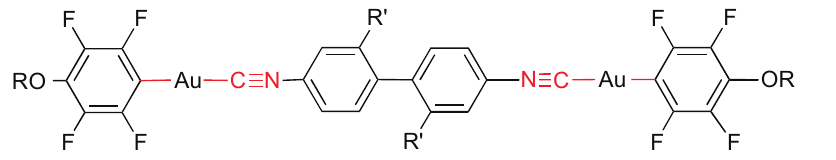
Figure 18. Isocyanide and perfluoroaryl gold mesogens. R = C